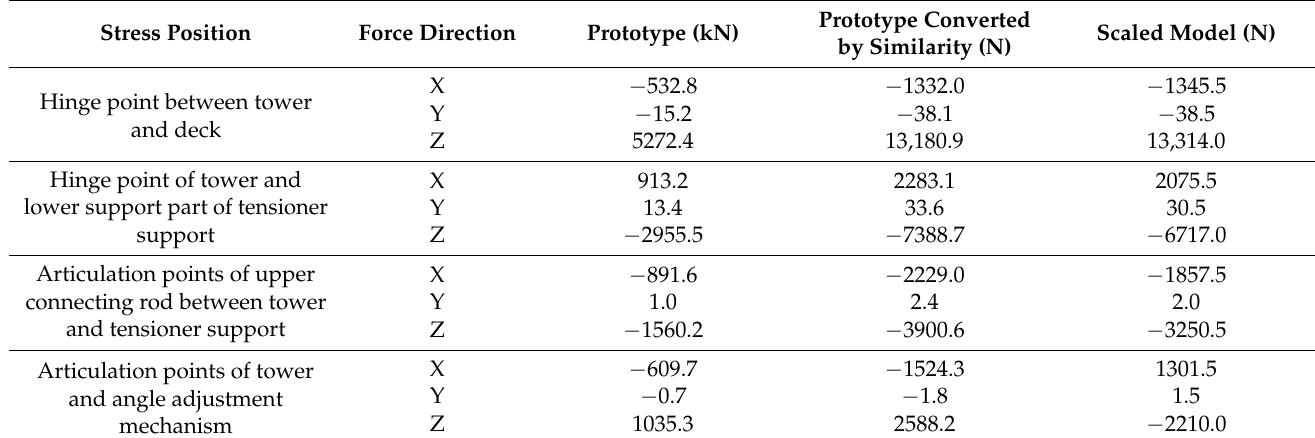
Table A4. Maximum force during piping laying.